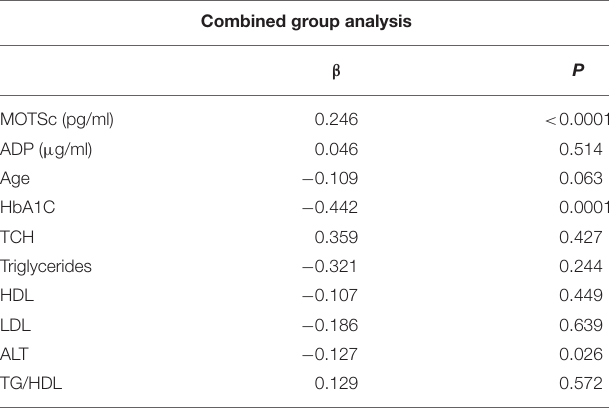
TABLE 2B | Multiple linear regression analysis of variables that showed significant association with HN.